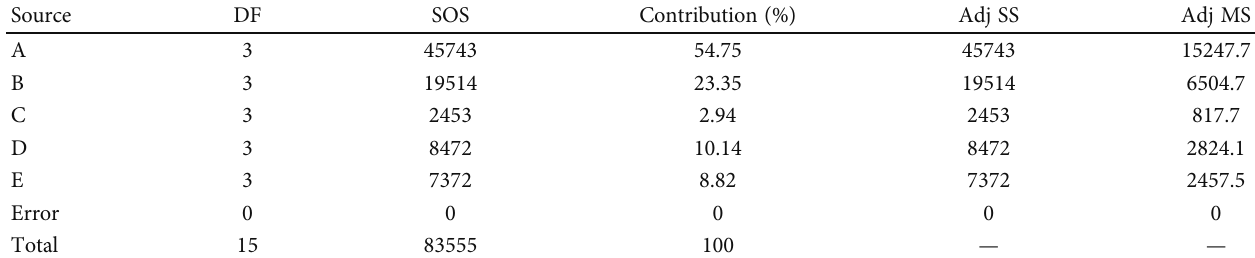
Table 4: ANOVA analysis of adsorptions of iodine in phenolic